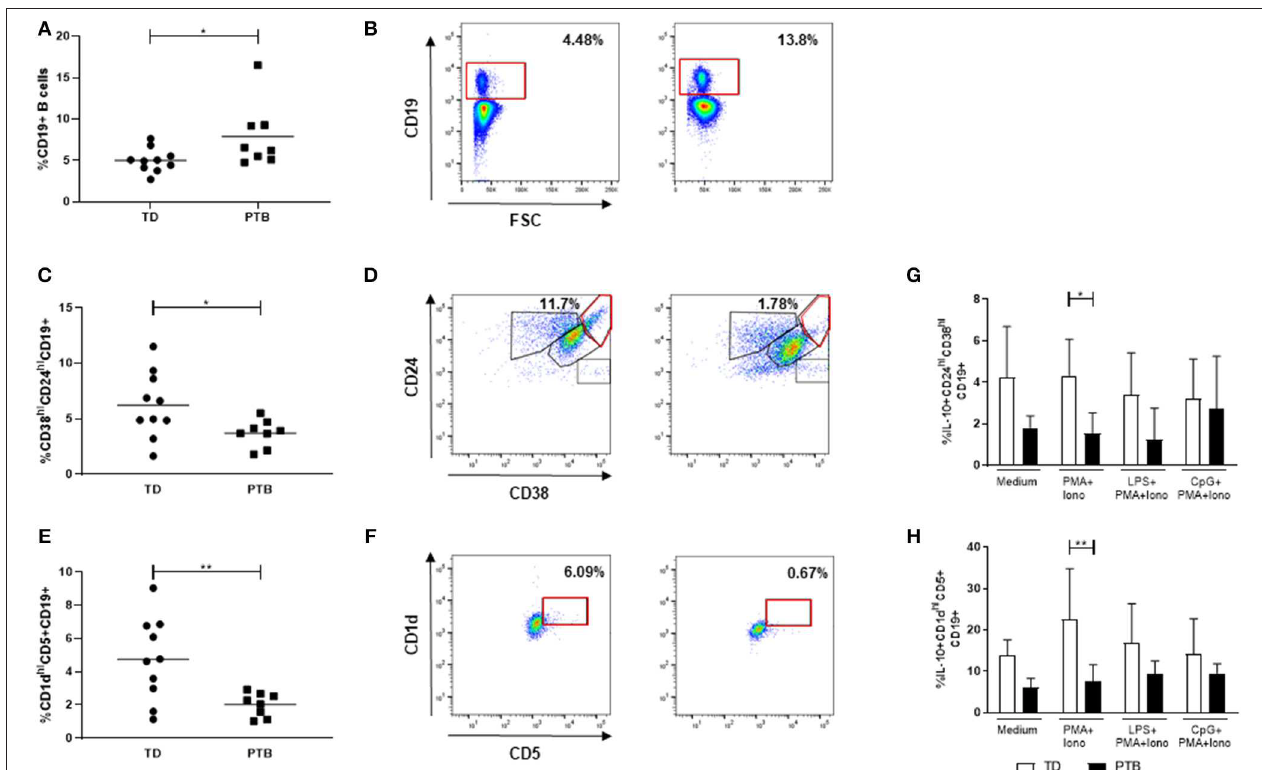
FIGURE 2 | Regulatory B cell populations in maternal blood before delivery. The percentage of CD19 + B cells (A) , CD38 hi CD24 hi CD19 + Breg cells (C) and CD1d hi CD5 + CD19 + Breg cells (E) and the corresponding gating strategies (B,D,F) were calculated within maternal blood obtained immediate before delivering. Data were analyzed by Mann-Whitney test. Shown is the mean value. PBMCs were stimulated for 5h in the presence of Brefeldin A alone or combined with PMA and ionomycin, partly added by LPS or CpG. Intracellular IL-10 secretion within the above-mentioned Breg populations was determined by flow cytometry. Data were analyzed using two-way ANOVA with Bonferroni’s multiple comparisons test, shown is the mean and SD. TD, term delivery; PTB, preterm birth; * p < 0.05; ** p < 0.005.